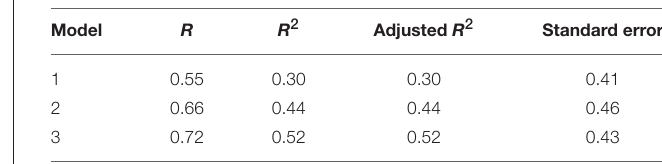
TABLE 1 | Results of the stepwise multiple regression